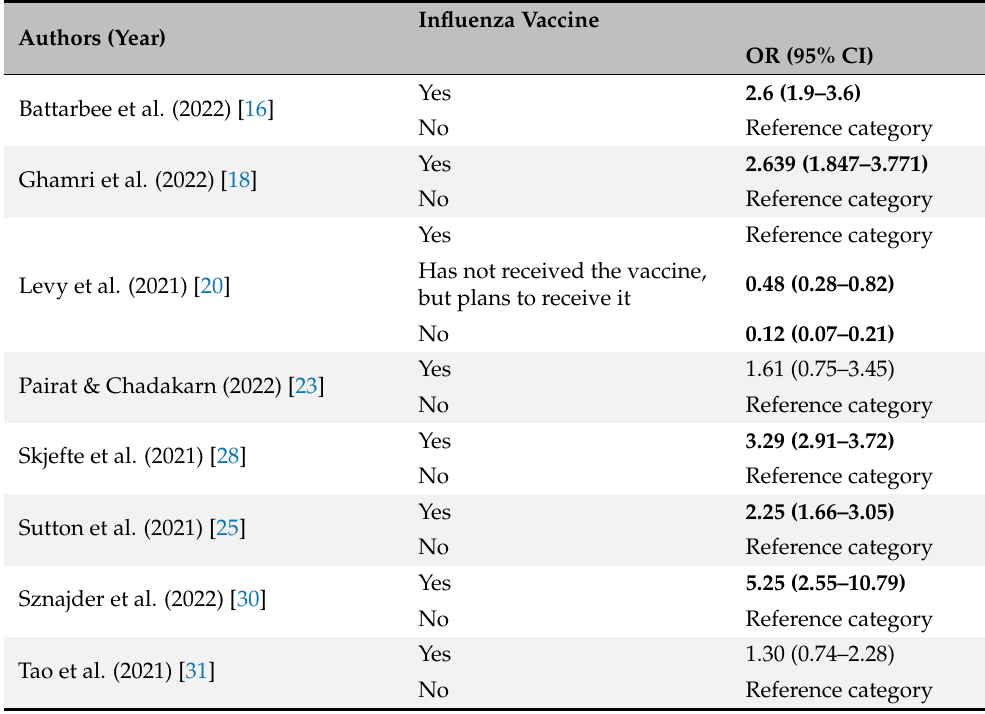
Table 3. Influenza vaccination as a factor of COVID-19 vaccination acceptance among pregnant